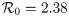
Time behaviour of the outer supervisory control loop for different FPSP periods.The periods range from 14 to 49 days. During non-lockdown, the epidemic evolves with parameters corresponding to a reproduction number R0=2.38. (Top) total amount of infected population. (Middle) Average reproductive number obtained with the duty-cycles shown in the lower panels. It can be noticed that, for each choice of the period T, the outer loop converges to a pair [X, Y] (whose exact values are highlighted with arrows of the corresponding colour in the two lower panels) that successfully suppresses the virus (see the convergence points in Fig 4).